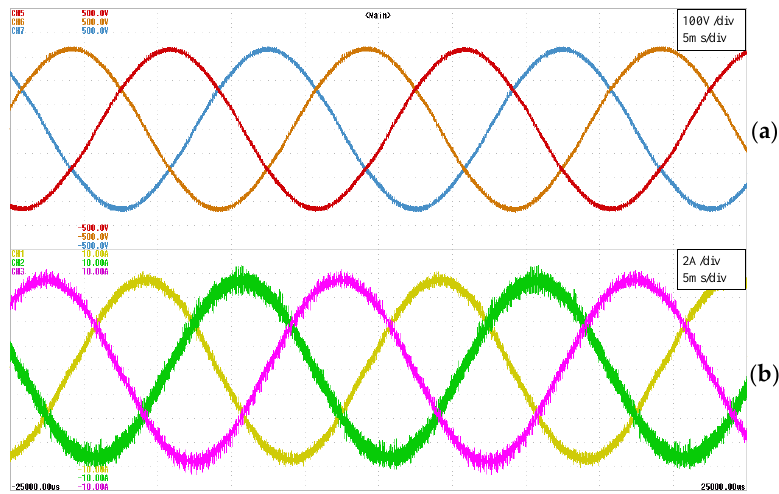
Figure 25. PS-SPWM operation with a 2 kW load. ( a ) line-to-line output voltages and ( b ) output currents.